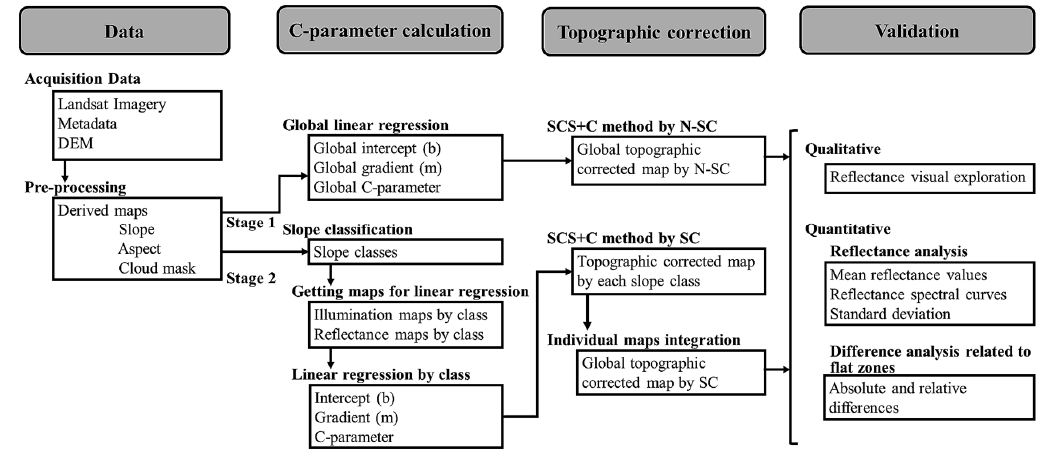
Figure 2. Methodology overview. Abbreviations: N-SC: non-slope classification; SC: slope classification. The resulting corrected images were visually (qualitatively) explored and numerically (quantitatively) validated based on the normalized reflectance values obtained.